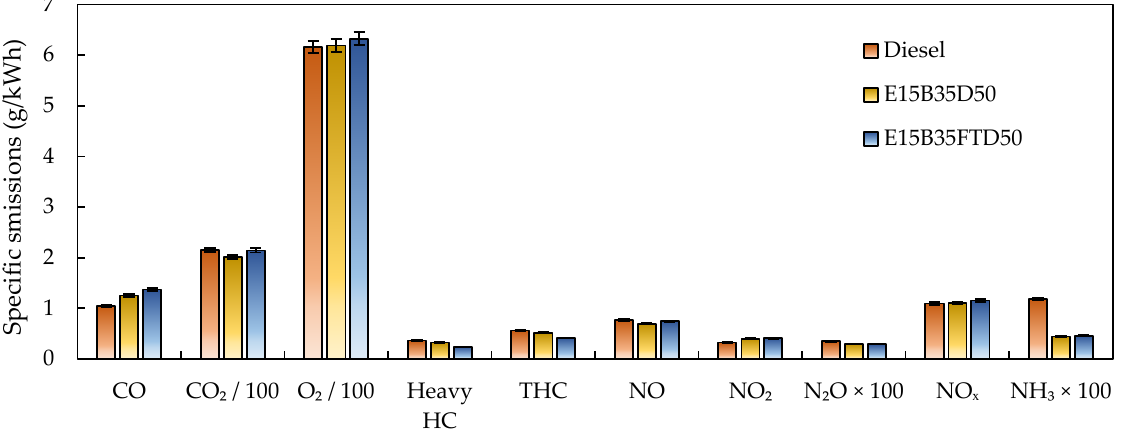
Figure 3. Exhaust gaseous emissions of diesel, E15B35D50, and E15B35FTD50. A slight decrease in CO 2 emissions was observed when the engine was fueled with E15B35D50, while CO 2 emissions for E15B35FTD50 are slightly higher than in the case of diesel fuel. This is in line with the carbon content of the estimated chemical formula of the fuel blends, though it has to be noted that the differences are within the confidence interval of the results. CO 2 is a common product of the combustion of hydrocarbon fuels so the lower carbon content of ethanol molecules leads to lower CO 2 formation, even on an en- ergy basis (g CO 2 /MJ fuel ). In addition, for combustion stoichiometry, previous studies re- ported that an increase in CO 2 emission with the addition of biofuels (ethanol and bio- diesel) is attributed to the higher oxygen content of the oxygenated, which favors the com- bustion process and hence increases CO 2 formation [54,55]. The combustion of E15B35D50 and E15B35FTD50 have reduced the THC emissions (mostly comprised of heavy unburned hydrocarbons) when compared to diesel fuel (Fig- ure 3). It has been reported in the literature that ethanol and biodiesel addition to diesel blends increase [56] or decrease [14] the hydrocarbons emission. The total and the heavy hydrocarbons presented in the THC have decreased between 18%–33% for E15B35FTD50 in comparison with diesel or E15B35D50. This might be associated with the higher cetane number and the absence of aromatics of F-T diesel, contributing to the reduction in THC. Khan et al. [57] discussed that a higher cetane number and lower aromatic content are the main reasons for the occurrence of a shorter ignition delay time. Moreover, the virtually zero sulfur as well as the absence of aromatics, have been mentioned to result in a reduc- tion in the engine-out exhaust emissions (i.e., reduce HC development and lowering PM) [58]. It has been previously reported in the literature that F-T diesel reduces hydrocarbons emissions [59] in comparison with diesel fuel. In this work, the addition of the oxygenated biofuels (ethanol and biodiesel) further reduced the unburned hydrocarbons emissions (Figure 3). The light-saturated HC (methane and ethane) and the unsaturated HC (acetylene, ethylene, and propylene) species, shown in Figure 4, have been separately analyzed from the heavy HC in order to provide an in-depth analysis of the THC. The heavy hydrocar- bons solely correspond to approximately 88%, 85%, and 78% of THC for diesel, E15B35D50, and E15B35FTD50, respectively. The decrease in the heavy HC (seen in Figure 3) follows the same trend for the blends as with the THC. On the other hand, higher emis- sions of the light HC species (saturated and unsaturated) were measured for the E15B35FTD50 and E15B35D50 as compared to diesel fuel. This result could be attributed to the thermal decomposition of the alcohol component of the blends into shorter mole- cules of HC (i.e., light HC species) and CO, as discussed by Fayad et al.[28]. Nevertheless, the combustion of diesel is likely to produce heavier HC, which supports the reduction of the THC for the blends.